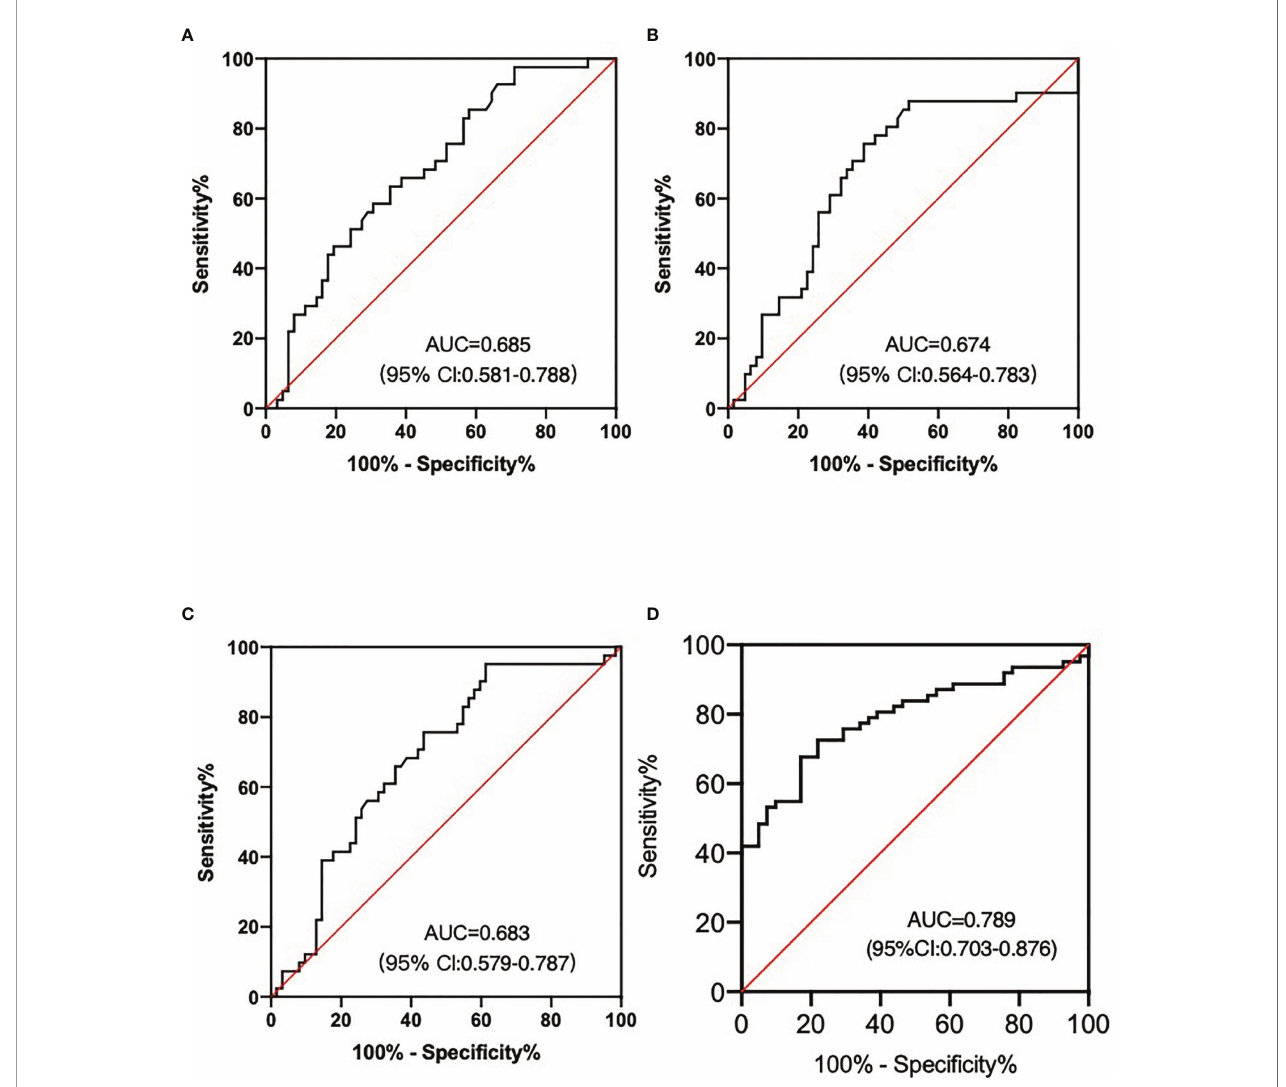
FIGURE 3 | LncRNA as the nodal ef fi cacy biomarkers after NAT for HER2+ breast patients. (A) The AUC of lncRNA-AL390243.1 was 0.685. (B) The AUC of POTEH-AS1 was 0.674. (C) The AUC of lncRNA-AC009975.1 was 0.683. (D) The diagnostic performance for their combination demonstrated the AUC of